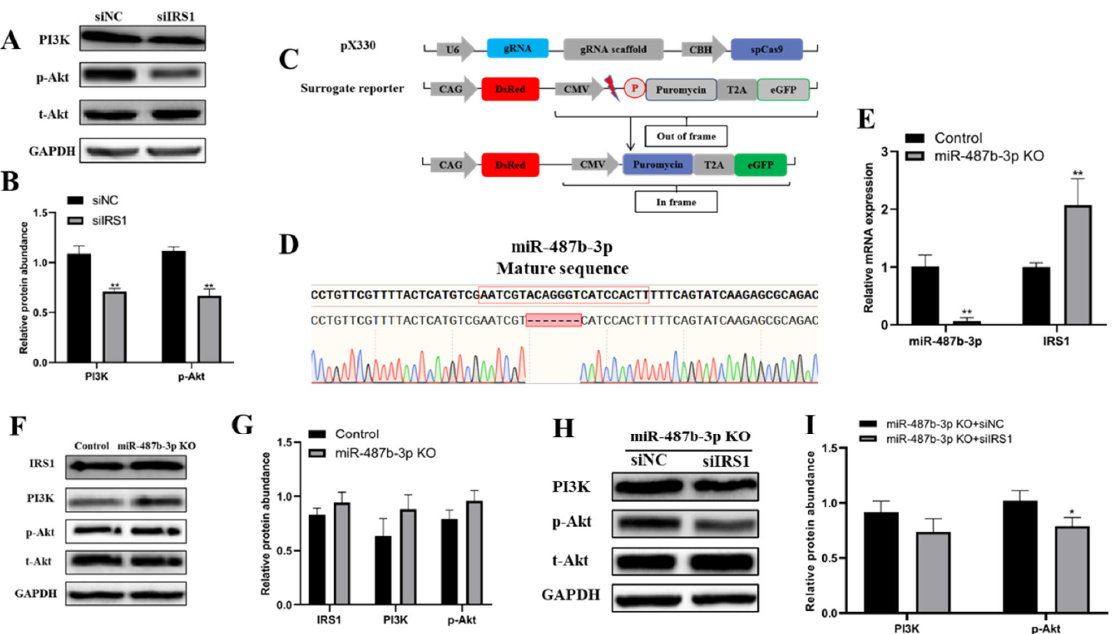
Figure 6. miR-487b-3p affects the IRS1/PI3K/Akt signaling pathway. ( A , B ) The protein Figure 6. miR ‐ 487b ‐ 3p affects the IRS1/PI3K/Akt signaling pathway. ( A , B ) The protein expression of PI3K, phosphor ‐ Akt (p ‐ Akt), and total Akt (t ‐ Akt) in goat myoblasts transfected with IRS1 siRNA and control siRNA. ( C ) Schematic diagram of the DsRed ‐ Puro r ‐ eGFP (RPG) surrogate reporter screening system including a sgRNA/Cas9 expression vector and a RPG surrogate reporter vector. ( D ) The sequencing results of the miR ‐ 487b ‐ 3p KO myoblast clone. The red box indicated the locus of deletion. ( E ) The expression of miR ‐ 487b ‐ 3p and IRS1 mRNA in the miR ‐ 487b ‐ 3p KO clone. ( F , G ) Western blot analysis result of PI3K, phosphor ‐ Akt (p ‐ Akt), and t ‐ Akt in miR ‐ 487b ‐ 3p KO myoblasts. ( H , I ) The protein expression of IRS1, PI3K, phosphor ‐ Akt (p ‐ Akt), and t ‐ Akt in miR ‐ 487b ‐ 3p KO myoblasts transfected with siNC or siIRS1. Data are shown by mean ± SEM of three independent experiments. * p < 0.05; ** p < 0.01.